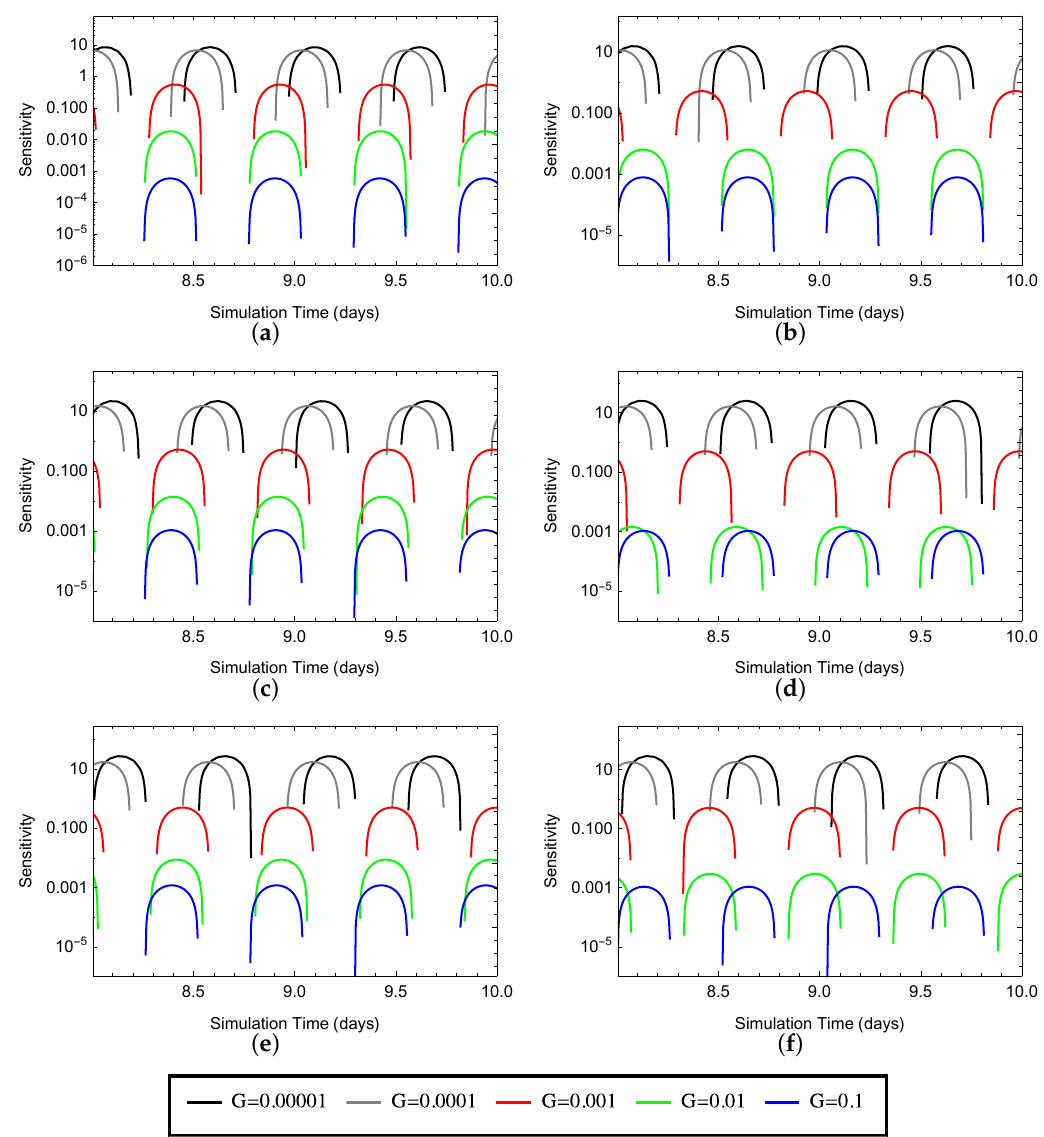
Figure 3. Elevation sensitivity to G , for simulations with different G values, at different locations on the 21-node linear sloping domain. The five different lines on each plot correspond to the five simulations, each with a different value of G as indicated in the legend below the figures. ( a ) Node 2; ( b ) Node 3; ( c ) Node 4; ( d ) Node 5; ( e ) Node 6; ( f ) Node